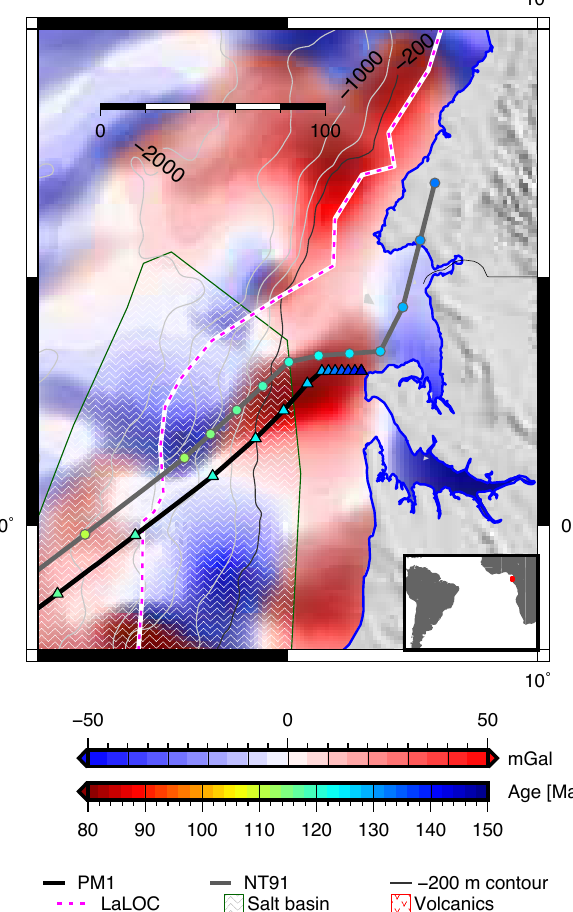
Fig. 10. Age-coded flowlines plotted on filtered free-air gravity basemap (offshore) for the north Gabon/Rio Muni segment of the African margin. Initial-phase flowline direction of our pre- ferred model (PM1, thin black line with circles) is perpendicular to the trend of the present-day coastline, striking NW–SE, and only turns parallel to oceanic transform zones (trending SW–NE) af- ter ≈ 126ma. Note that models PM4 & PM 5 induce a signifi- cant amount of compression for the initial phase of relative plate motions and do not agree with geological observations from the area. Relative motions between SAf and SAm in model NT91 com- mence at 131ma. Circles are plotted in 2 Myr time intervals start- ing at 144Ma and from 132Ma for NT91 (N¨urnberg and M¨uller, 1991; Torsvik et al., 2009). Legend abbreviations: LaLOC – Land- ward limit of oceanic crust; C. – Contour. Free-air gravity anoma- lies (Sandwell and Smith, 2009) filtered with 5th-order Butterworth low-pass filter with 35km wavelength.